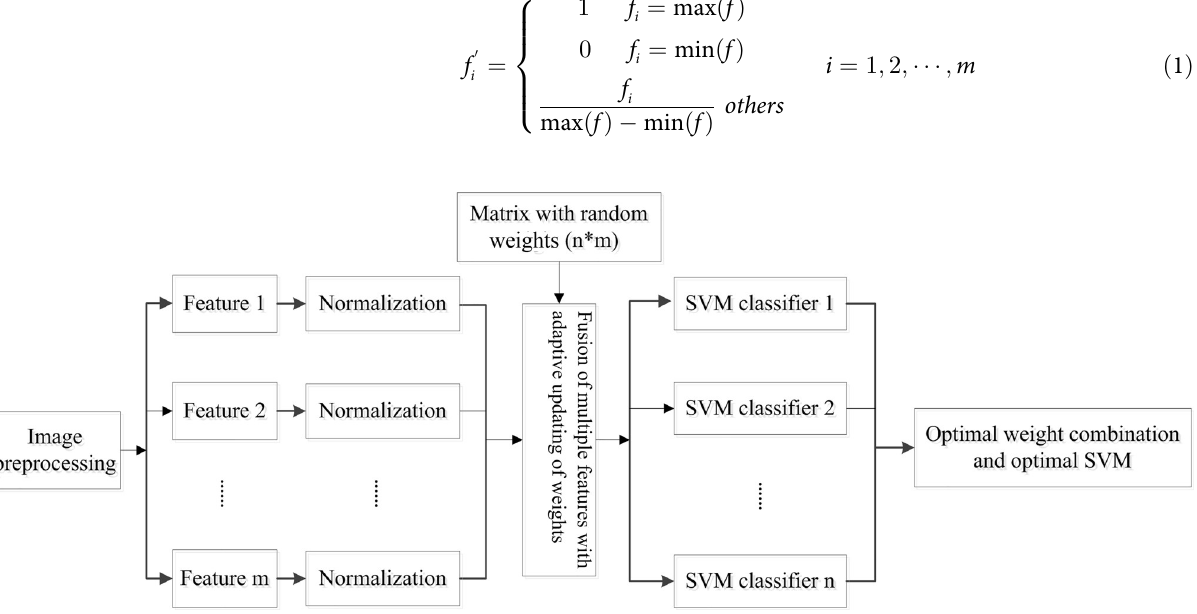
Fig 2. Framework of the AFWU-SVM